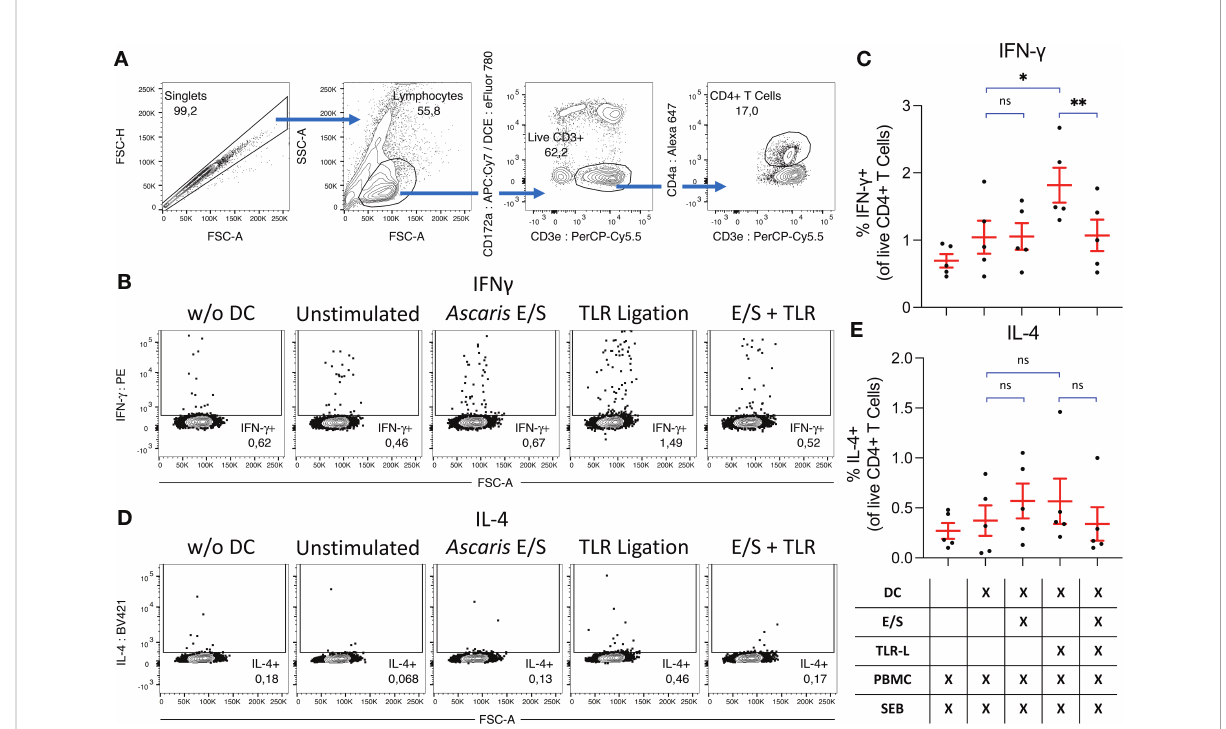
FIGURE 5 Ascaris E/S prevents SEB-driven T cell activation by TLR-activated DC. (A) Representative gating strategy used to identify CD4+ T helper cells. Cells aggregates were excluded, and lymphocytes selected on the basis of size and granularity. CD172a- CD3e+ T cells were selected, and within this population CD4+ T helper cells were identi fi ed. During previous DC subset sorting, pDC were labelled with CD4a-PerCP-Cy5.5, and these cells appear as a false “ CD172a+ CD3e+ ” population due to re-use of the PerCP-Cy5.5 fl uorophore. Since all DC subsets are CD172a+, we can be sure that the CD172a- population has not previously been exposed to labelling and thus the CD172a- CD3e+ population constitutes a true T cell population. (B) Representative intracellular IFN- g staining of CD4+ T cells from PBMC cultured without DC (left), or co-cultured with DC which were unstimulated, or stimulated with Ascaris E/S, TLR ligation, or E/S + TLR ligation. (C) Percentage IFN- g + CD4+ T cells identi fi ed under each treatment condition. Treatments are displayed in the grid below. Each dot represents cells from a different pig, n=2. (D) Intracellular IL-4 staining of CD4+ T cells from PBMC cultured without DC (left), or co-cultured with DC which were unstimulated, or stimulated with Ascaris E/S, TLR ligation, or E/S + TLR ligation. (E) Percentage IL-4+ CD4+ T cells identi fi ed under each treatment condition. Treatments are displayed in the grid below. Each dot represents cells from different pig, n=5. Asterisks indicate statistical signi fi cance by paired t test with Bonferroni correction; * p ≤ 0.017, ** p ≤ 0.0033. ns, not signi fi